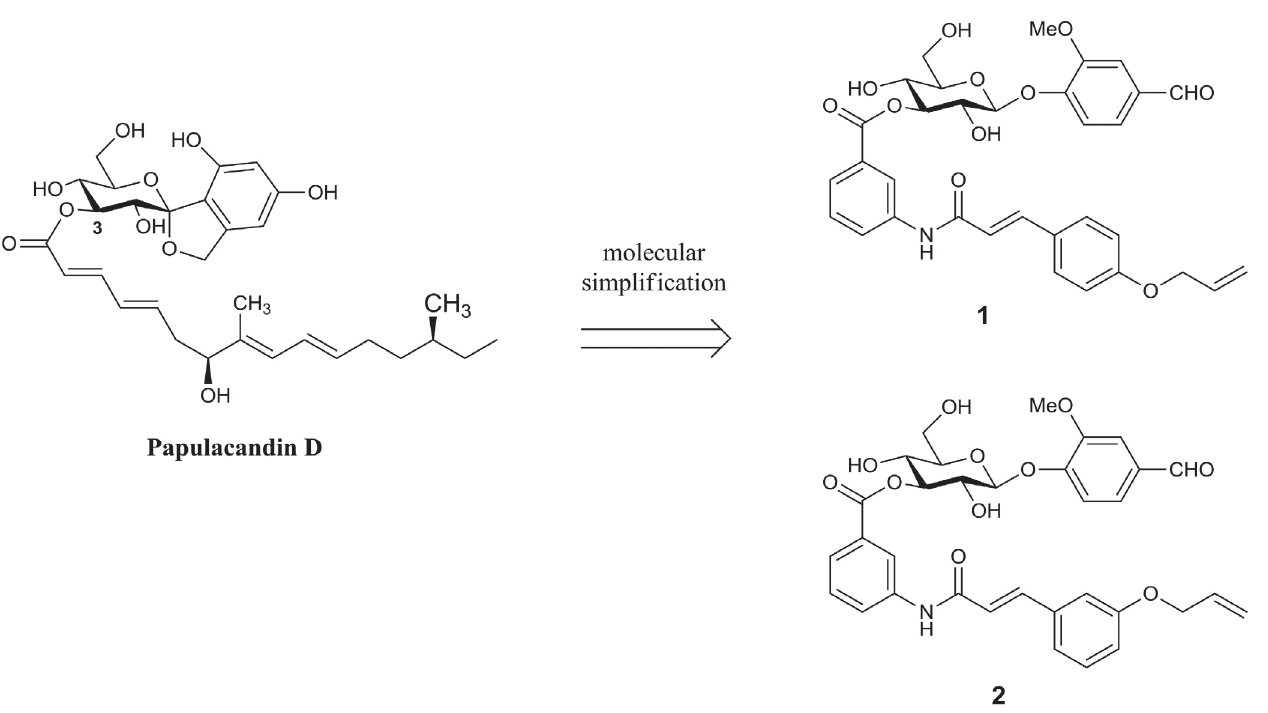
FIGURE 2 - Chemical structures of proposed new analogs of papulacandin D by molecular